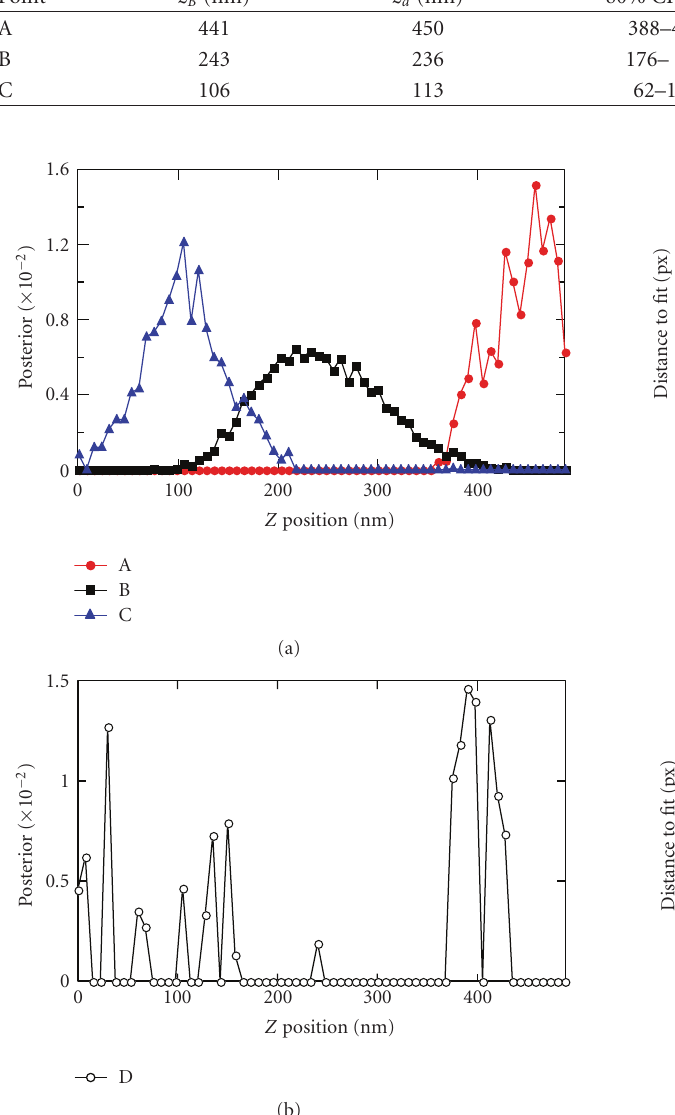
Figure 3: Posterior probability distributions for points A–D from Figure 1(c).